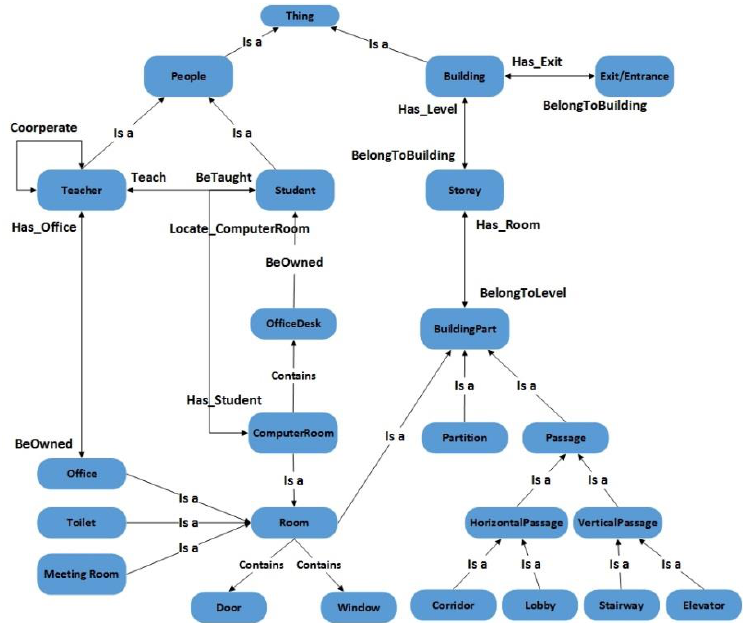
Figure 3. The Ontology Model for Semantic